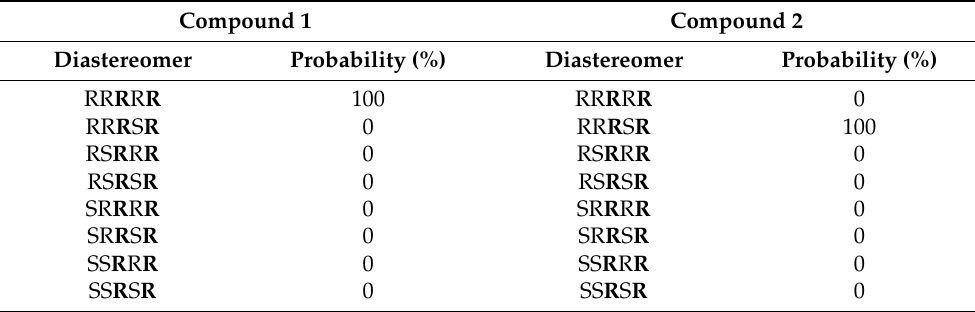
Table 3. DP4+ probabilities of two 6-epimers of 6-hydroxyhippeastidine. Two bold letters R stand for the fixed configuration of the 5,10b-ethanobridge with respect to the crinine-type skeleton (3,4,5 R ,6,10b R ).